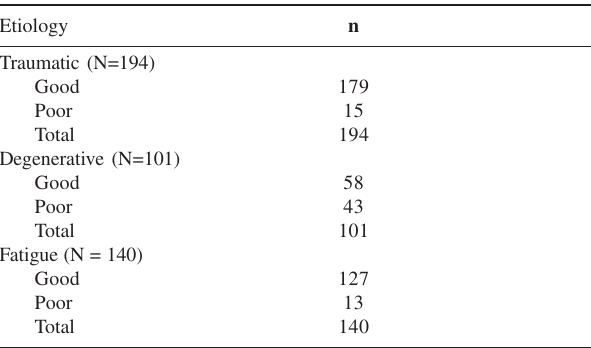
Table 6 - Treatment results according to the etiology of the